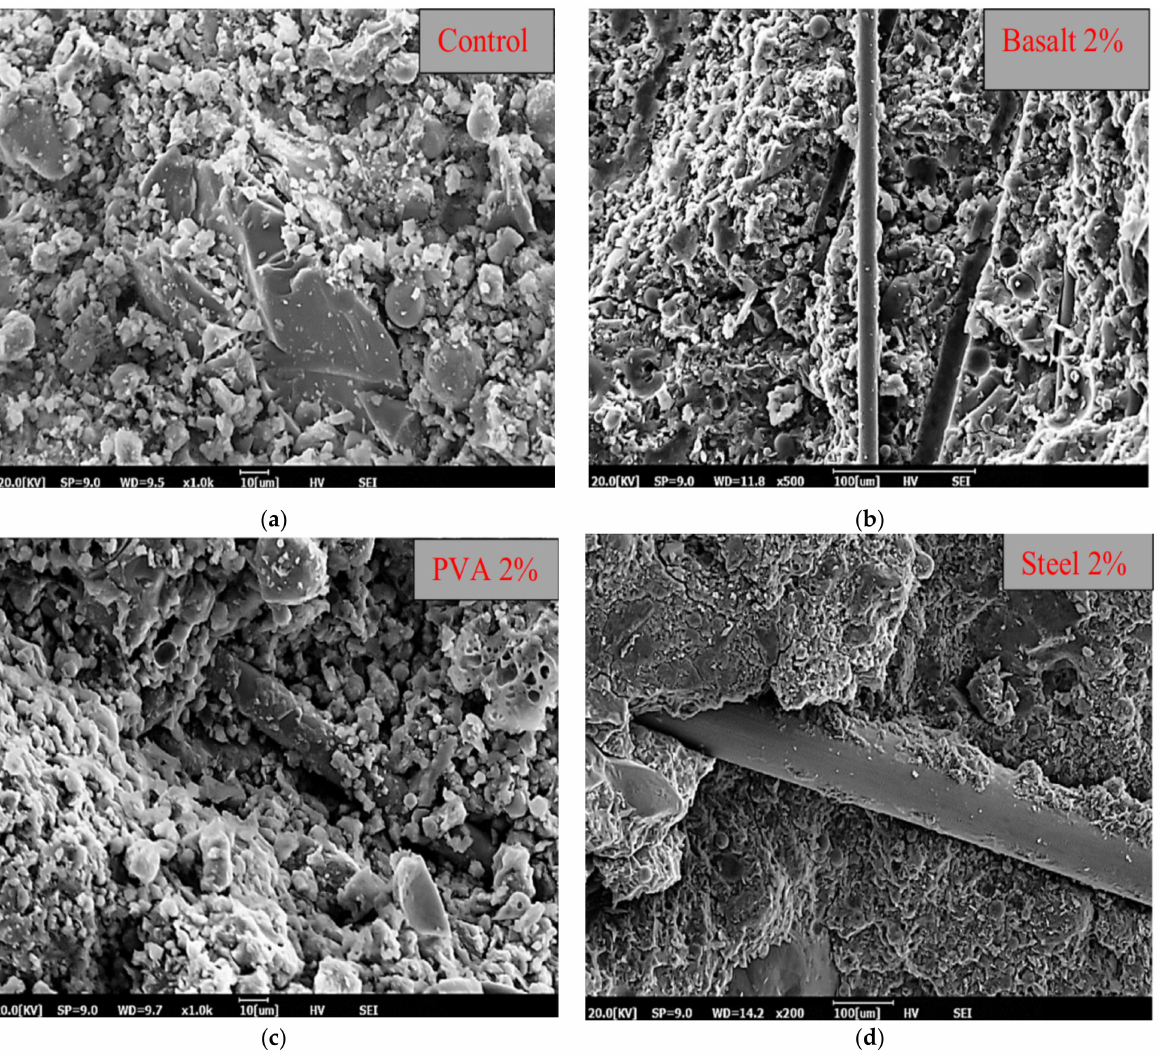
Figure 6. SEM images of FOPGs. ( a ) control, ( b ) basalt fiber, ( c ) PVA fiber and ( d ) steel fiber. Adapted with permission from [66], copyright 2020